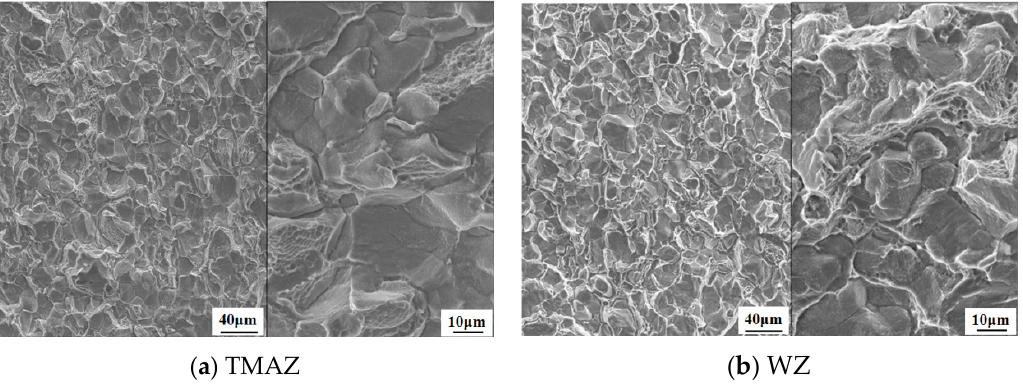
Figure 16. Fractured zone on the fracture surface of the test piece.